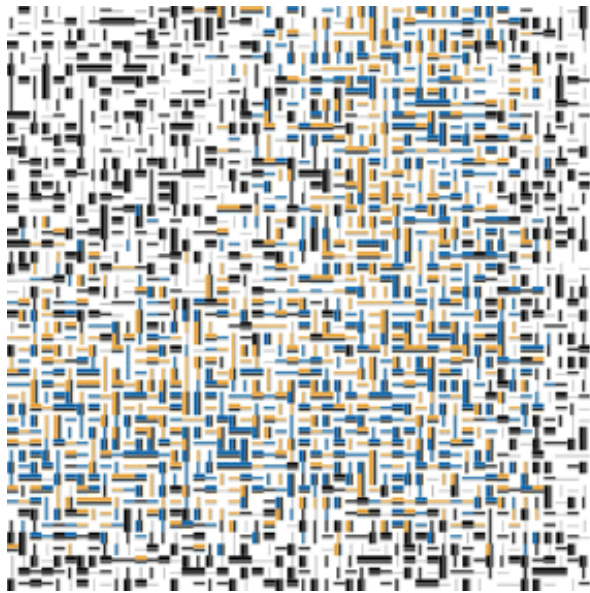
Figure 3. Frieder Nake: Abteiberg Walk through Raster,